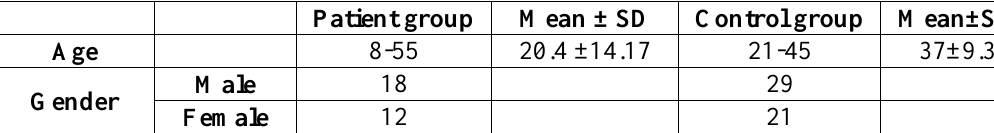
Table (1): Age and gender for both patient and control group.